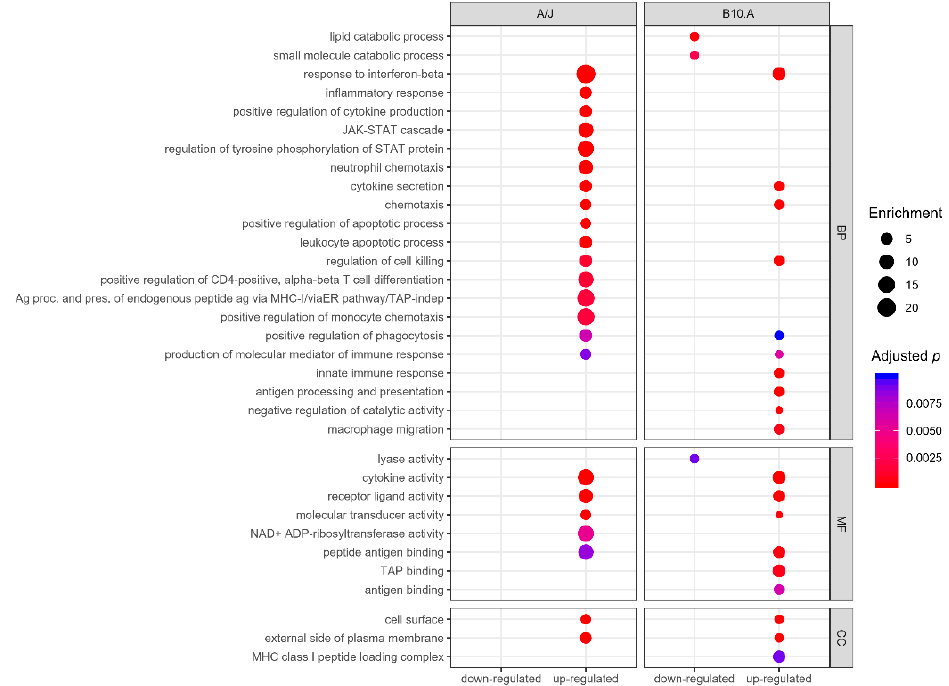
Figure 2. Gene ontology enrichment of differentially expressed genes in BMDCs after P. brasiliensis infection. Enriched ontological categories (adjusted p -value < 0.01) associated with up- or downregulated DEG in BMDCs derived from the resistant A/J ( left ) and the susceptible B10.A ( right ) mice strains. Dot size represents the enrichment (gene modulated ratio/gene background ratio) for each GO term. BP: biological process, MF: molecular function, CC: cellular component.